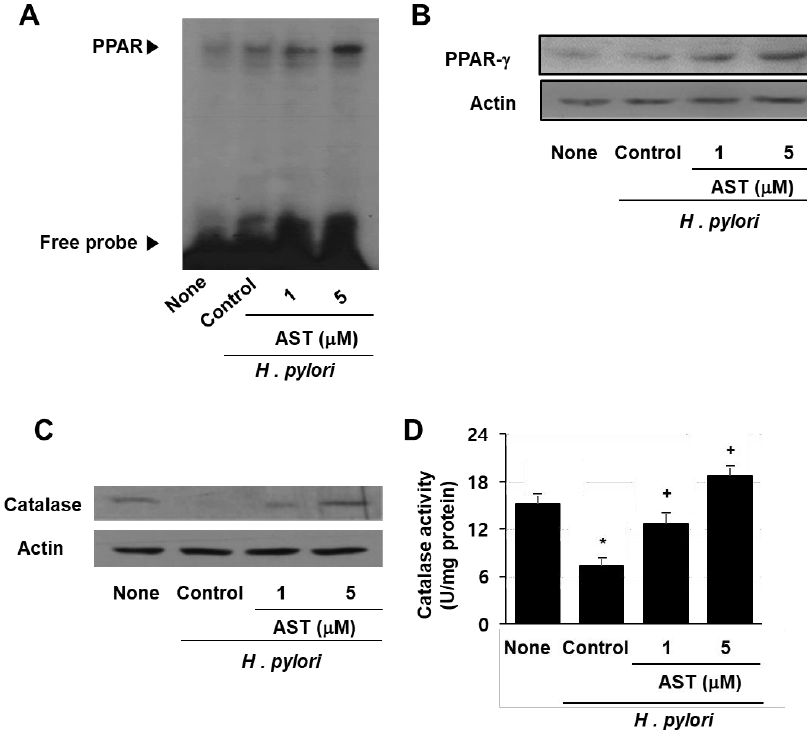
Figure 4. The effect of astaxanthin on the expression and activation of PPAR- γ and catalase in H. pylori –infected AGS cells. The cells were pre-treated with the indicated concentrations of astaxanthin for 3 h and then stimulated with H. pylori for 1 h. ( A ) DNA binding activity of PPAR was determined by EMSA. ( B ) Protein level of PPAR- γ was determined by Western blot analysis. ( C ) Protein level of catalase was determined by Western blot analysis. ( D ) Catalase activity in the sample was determined by catalase assay kit. * p < 0.05 vs. none (cells without any treatment or stimulation); + p < 0.05 vs. control (cells with H. pylori stimulation